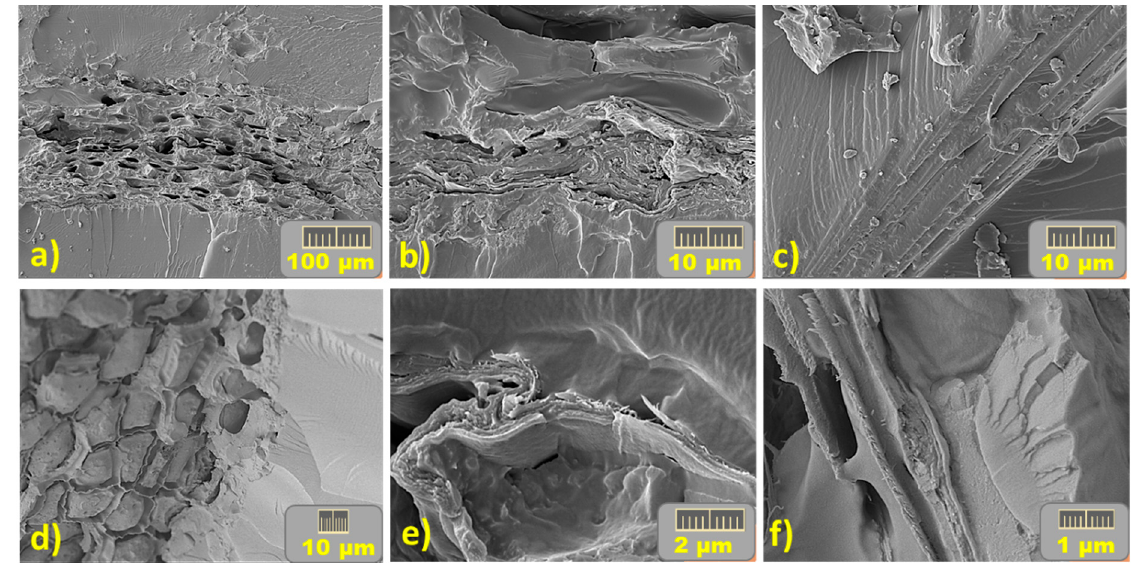
Figure 9. SEM micrograph of the ELO-based formulations filled with HC at ( a ) 100 µm, ( b ) and ( c ) 10 µm, ( d ) 2 µm, ( e , f ) 1 µm.